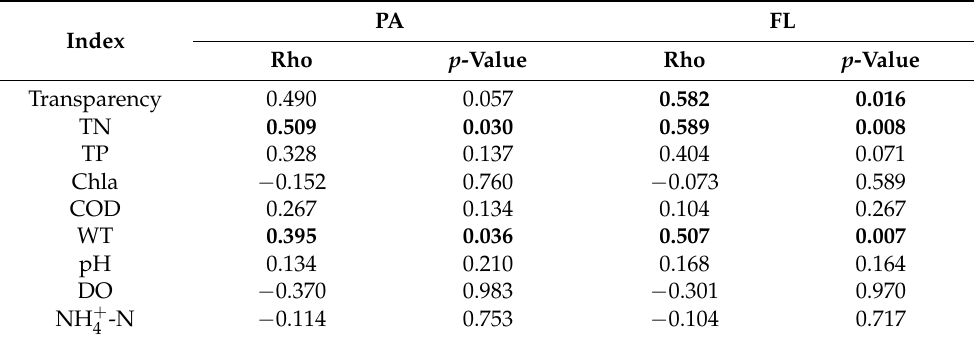
Table 1. Mantel test of bacterial abundance and environmental